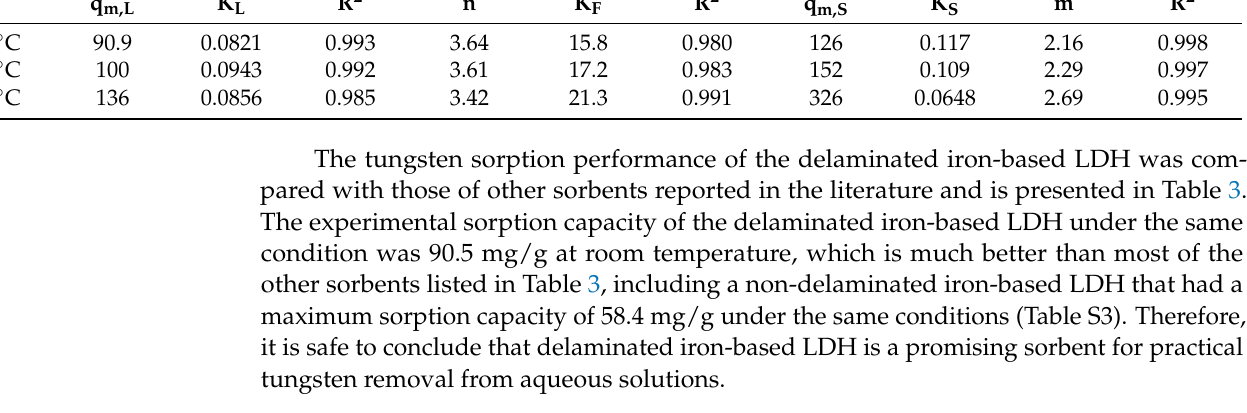
Table 3. Sorption capacities of various sorbents for